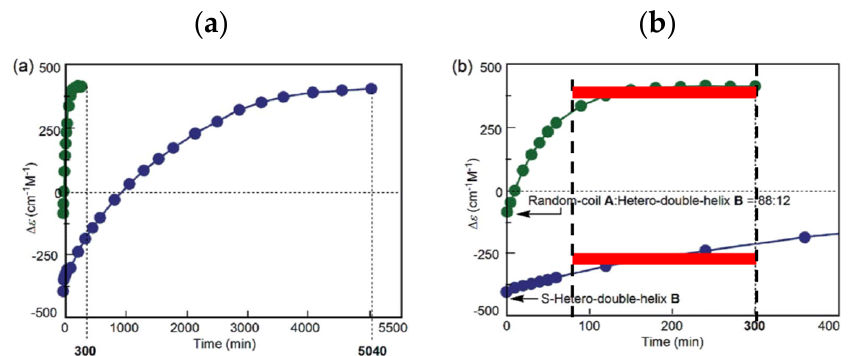
Figure 18. ( a ) Chemical kinetics of ( P )– 7 and ( M )– 8 in fluorobenzene (0.5 mM) at 25 ◦ C by the procedures of rapid cooling to − 10 ◦ C and rapid heating to 25 ◦ C (green line), and cooling from 70 to − 10 ◦ C at a rate of 2 K min − 1 and rapid heating to 25 ◦ C (blue line). ( b ) Expansion of ( a ) at the initial state. Red bold lines indicate bistability. Reproduced from ref. [66].